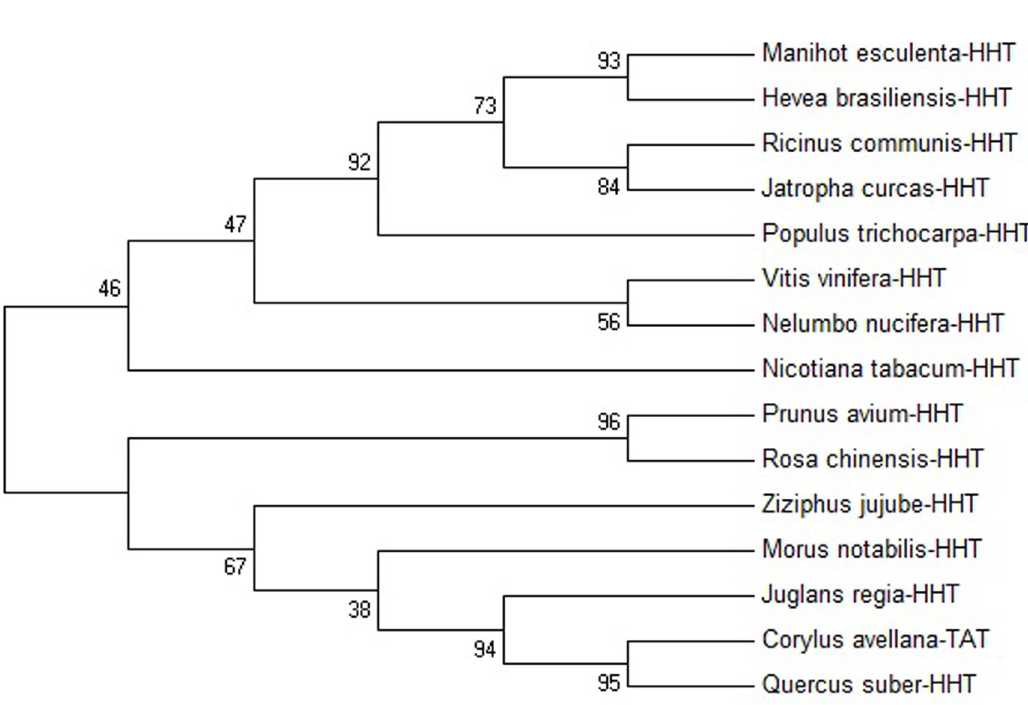
Fig 2. Phylogenetic analysis of identified TDAT of C . avellana with HHT to another plant that had high identity.